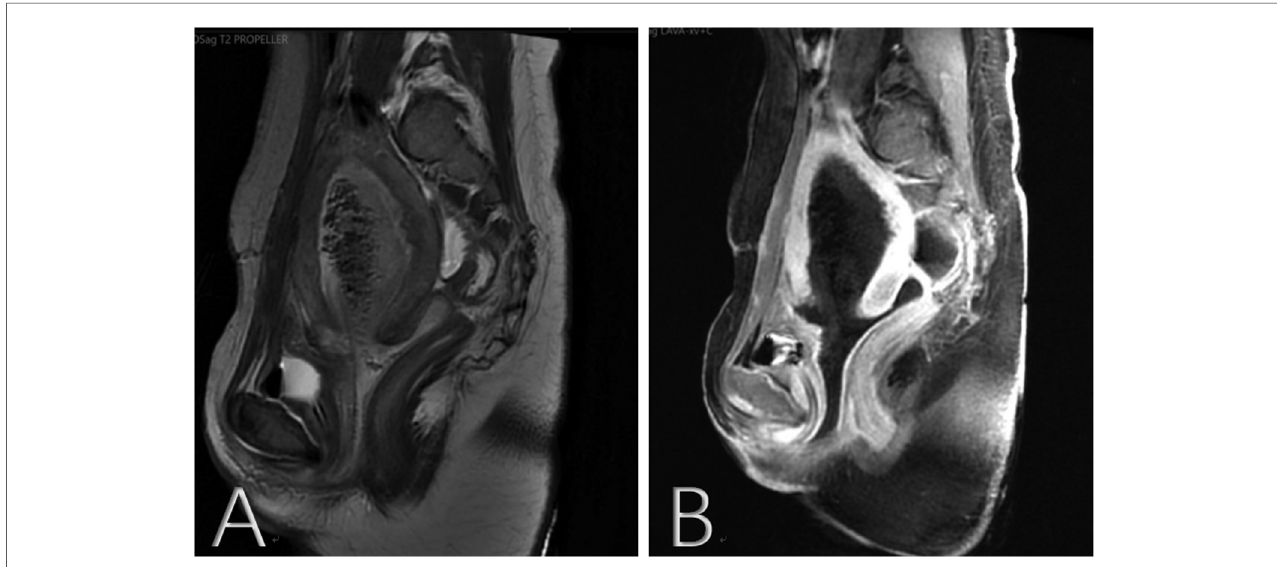
FIGURE 3 ( A ) T2-weighted MRI images of the pelvis found uneven signals in the myometrium of the uterus, slightly lower signal mass near the bottom of the posterior wall of the uterus, no diffusion limitation in DWI, slightly uneven lower signal in the intrauterine, scattered gas signal, and slightly uneven lower signal in the